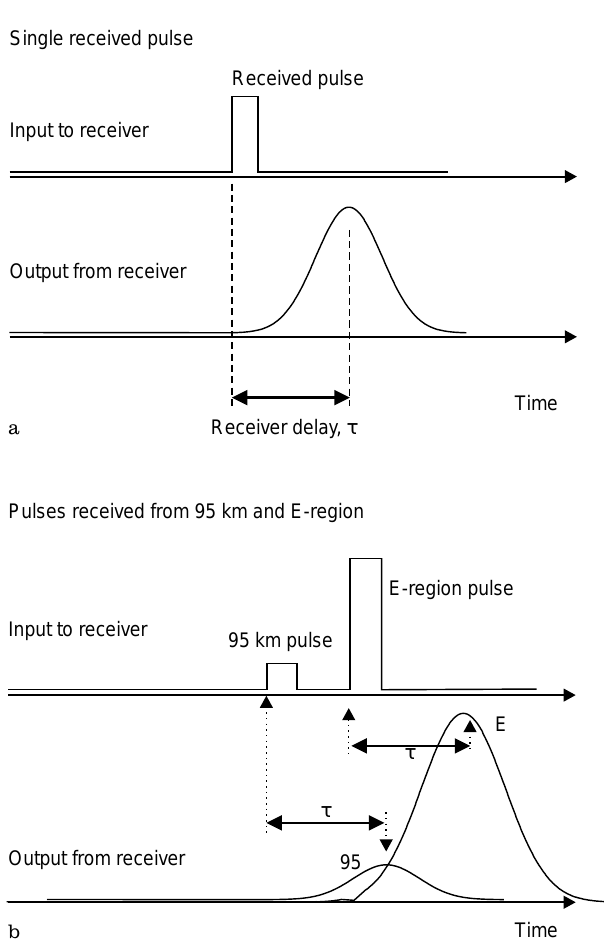
Fig. 7a. Schematic diagram showing the e(cid:128)ect of passing a pulse through a receiver. Note especially the final Gaussian shape and delayed peak. b Schematic diagram showing the output of a typical receiver with two incident pulses, the second slightly delayed from the first. The first pulse to arrive also has a much weaker amplitude. See text